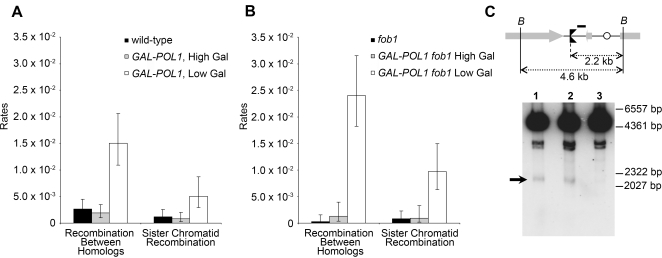
Comparison of mitotic rDNA recombination rates and DSBs near the RFB.(A) Rates of mitotic rDNA recombination between homologues and sister chromatids in wild-type cells (rich growth medium), and GAL-POL1 cells grown on media with either high or low galactose levels. Recombination between homologues is the sum of all RCO and BIR categories (Table 1). 95% confidence intervals are shown. (B) Rates of mitotic rDNA recombination in fob1 cells (rich growth medium) and GAL-POL1 fob1 cells grown on media with either high or low galactose levels. (C) DSBs near the RFB in wild-type cells (lane 1), GAL-POL1 cells grown in low galactose (lane 2), and fob1 cells (lane 3). In the diagram, the key is: 35S rRNA (large gray arrows), 5S rRNA (small grey arrow), RFB (black double triangles), replication origins (open circles), and BglII sites (B). DNA was isolated, and treated with BglII. The resulting fragments were examined by Southern analysis, using rDNA probe #1 (shown as short horizontal bar). The 2.2 kb fragment representing the DSB at the RFB (marked with a black arrow) is evident in lanes 1 and 2, but not in 3.